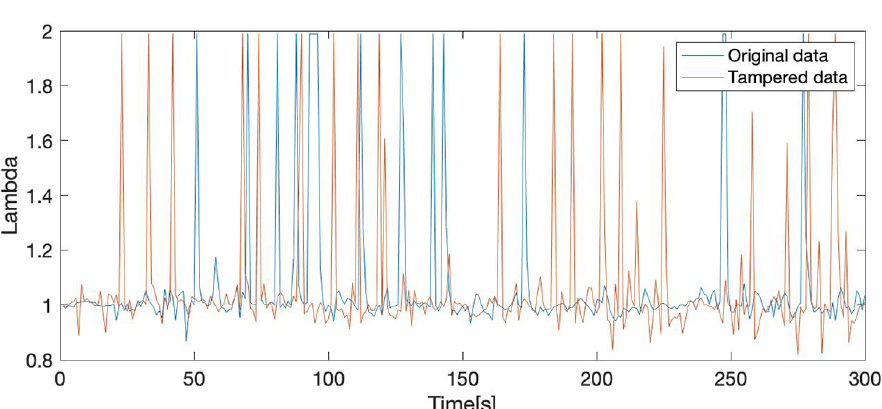
Figure 4. Lambda sensor ( Current of oxygen sensor ) values for the original and the tampered data sets: original data values (blue) and tampered data values (orange).